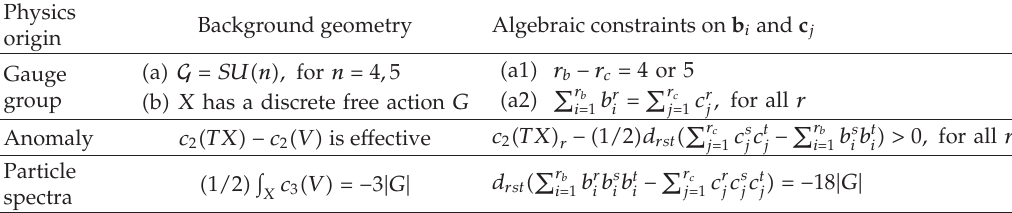
Table 2: The list of standard-like constraints on the N (cid:2) 1 heterotic vacua, each described by a Calabi- and c r parameterise the bundle V as in (cid:5) 3.1 (cid:6) , Yau threefolds X and a G -bundle V thereon; the integers b r i j where i (cid:2) 1 ,...,r b , j (cid:2) 1 ,...,r c , and r (cid:2) 1 ,...,h 1 , 1 (cid:5) X (cid:6) . The second column states the constraints on the background geometry, and the third column expresses the corresponding algebraic equations that the (cid:19) and c r must obey, where d rst (cid:2) J r ∧ J s ∧ J t are the intersection numbers for a parameters b r i j X